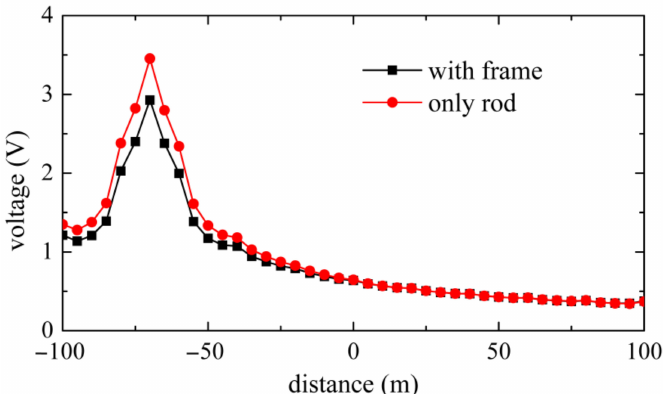
Figure 9. Peak of the potential along Line B.